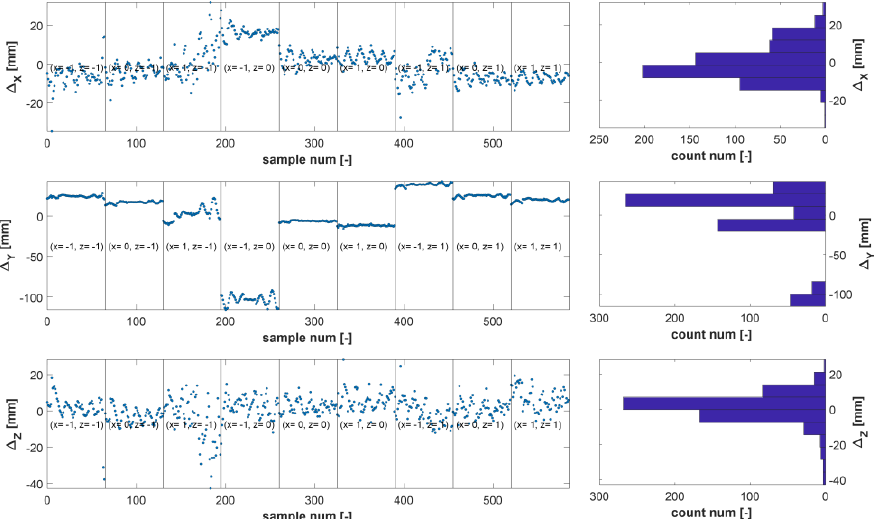
Figure 8. The trueness of the tracker position measurements for the individual components ( left ) and their histograms ( right ).